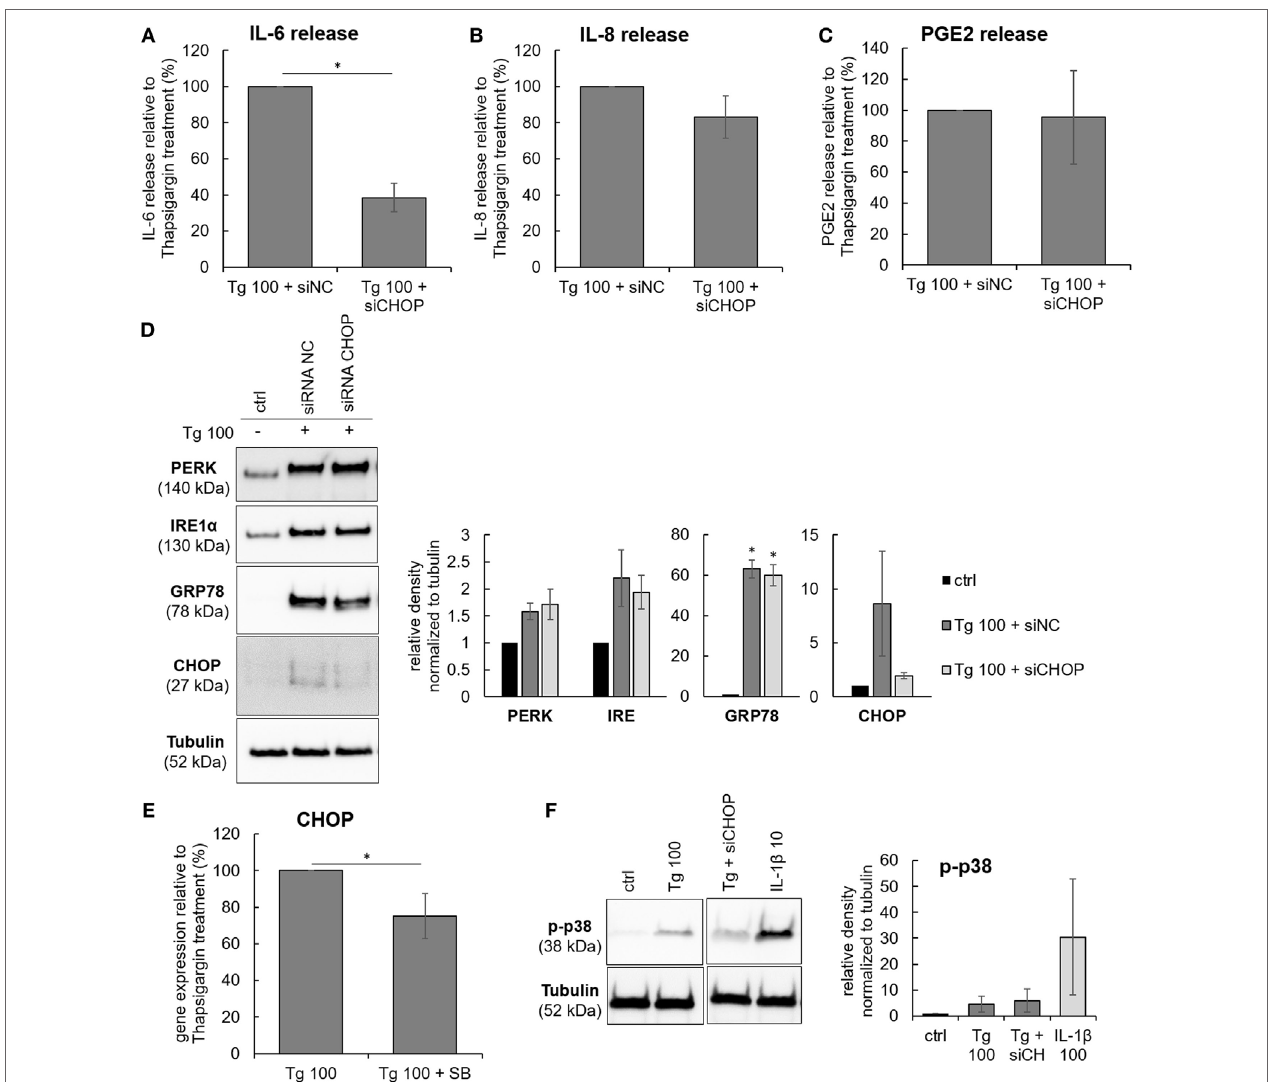
FigUre 5 | The effects of C/EBP homologous protein (CHOP) knockdown on the protein release of IL-6, IL-8, and PGE2. Cells were isolated from degenerated lumbar intervertebral discs (IVDs) and treated with 100 nM thapsigargin (Tg) in combination with 5 nM negative control siRNA (siRNA NC, scrambled) or 5 nM siRNA against CHOP (siCHOP). (a–c) CHOP knockdown reduced the release of IL-6, but not IL-8 and PGE2 ( n = 3 donors). (D) Tg-activated endoplasmic reticulum stress, as shown by expression of GRP78, PERK, IRE1 α , and their downstream effector CHOP. siRNA produced partial knockdown of CHOP gene. (e) p38 inhibition partially reduced gene expression of CHOP in Tg-treated cells ( n = 4 donors). (F) CHOP knockdown did not reduce p38 phosphorylation by Tg ( n = 3 donors). Data are presented as mean ± SEM, * p < 0.05 (ANOVA with Tukey post hoc